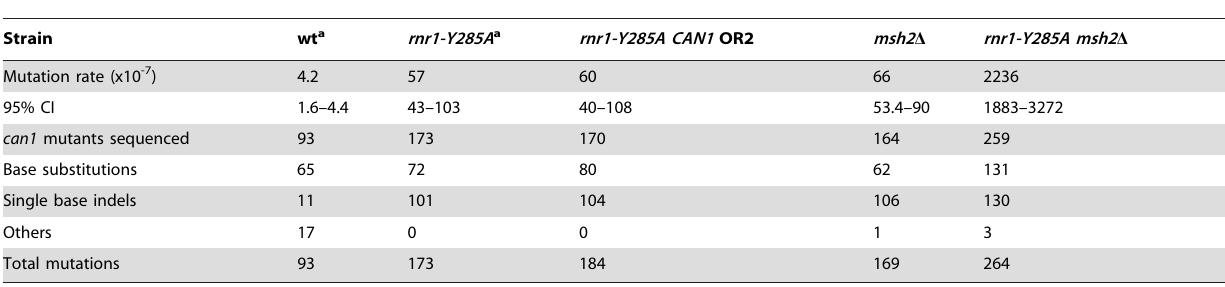
Table 1. CAN1 mutation rates and observed events. a